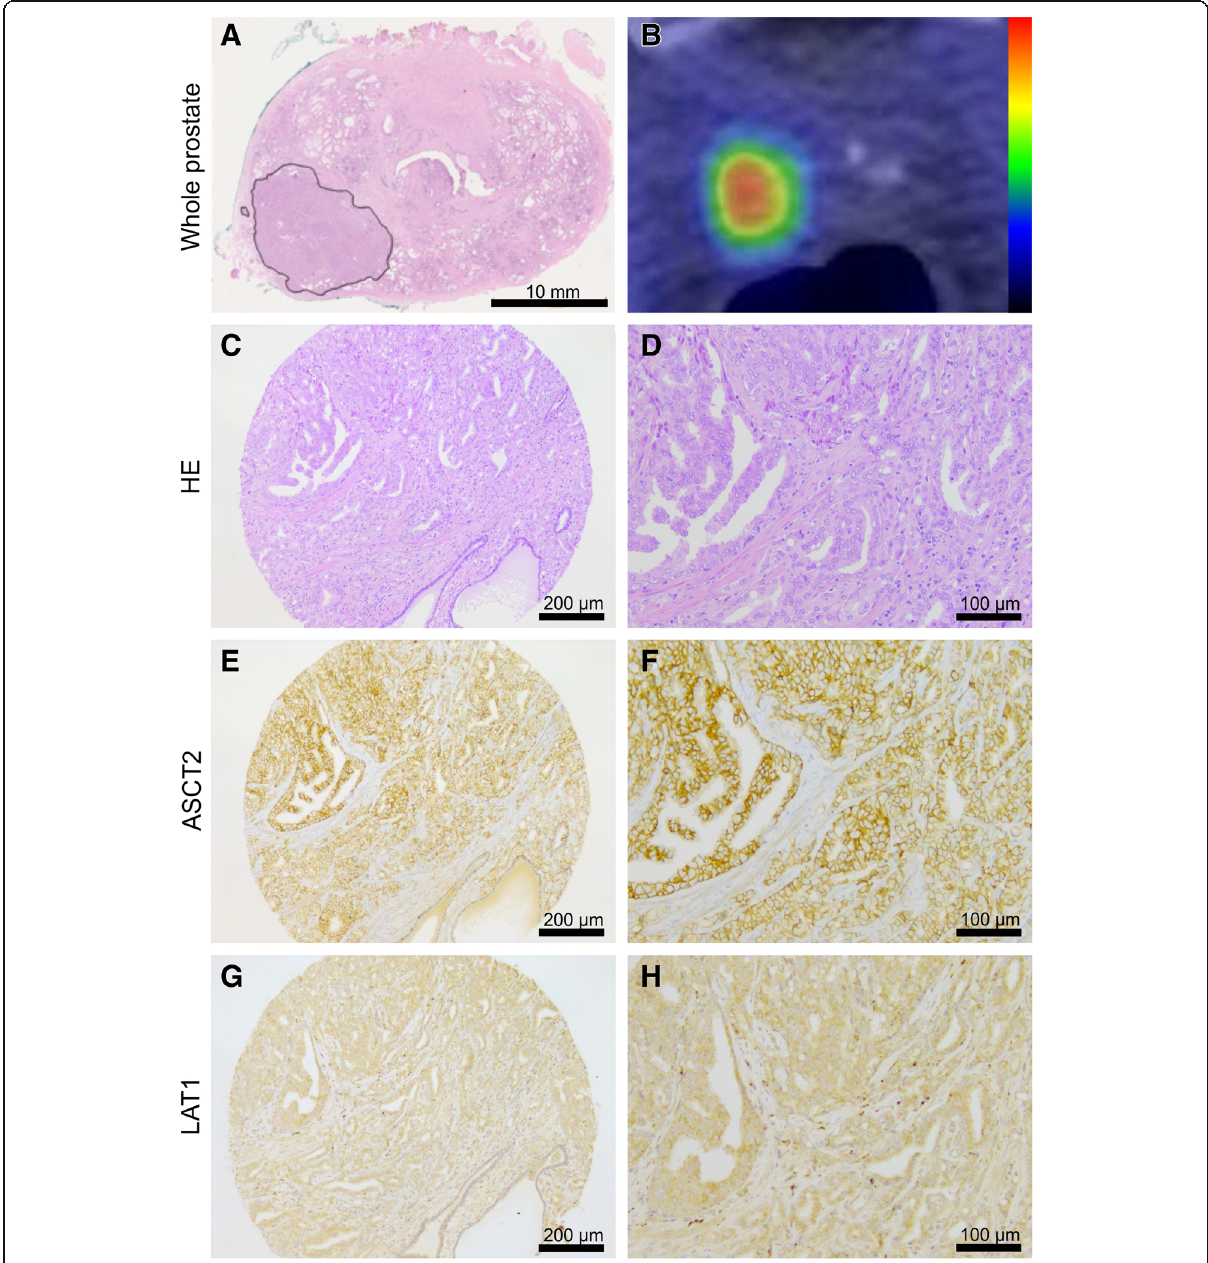
Fig. 5 A representative case of a 66-year-old patient with preoperative PSA of 4.6ng/ml. HE staining of the whole mount prostatectomy section indicates a solitary lesion in the right peripheral lobe ( a ). Axial PET/CT shows conspicuous high 18 F-fluciclovine uptake (SUV max at 22min=9.5) in the tumor ( b ). Low (×10, scale bar 200 μ m) and high magnification (×20, scale bar 100 μ m) images of HE-stained TMA core from the tumor show Gleason 4+5 adenocarcinoma ( c , d ). Parallel sections used for immunohistochemistry show high ASCT2 ( e , f ) and moderate LAT1 ( g , h ) staining